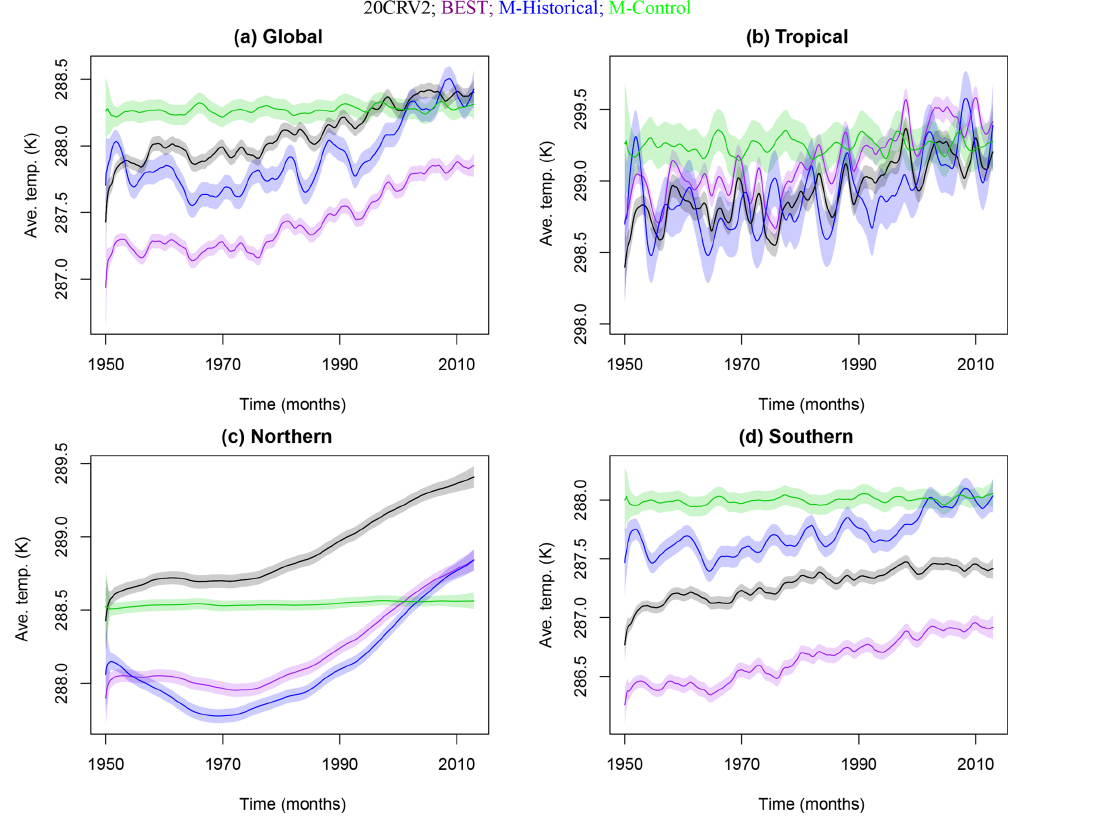
Figure 6. Same as in Fig. 2 but for the long-term analysis.